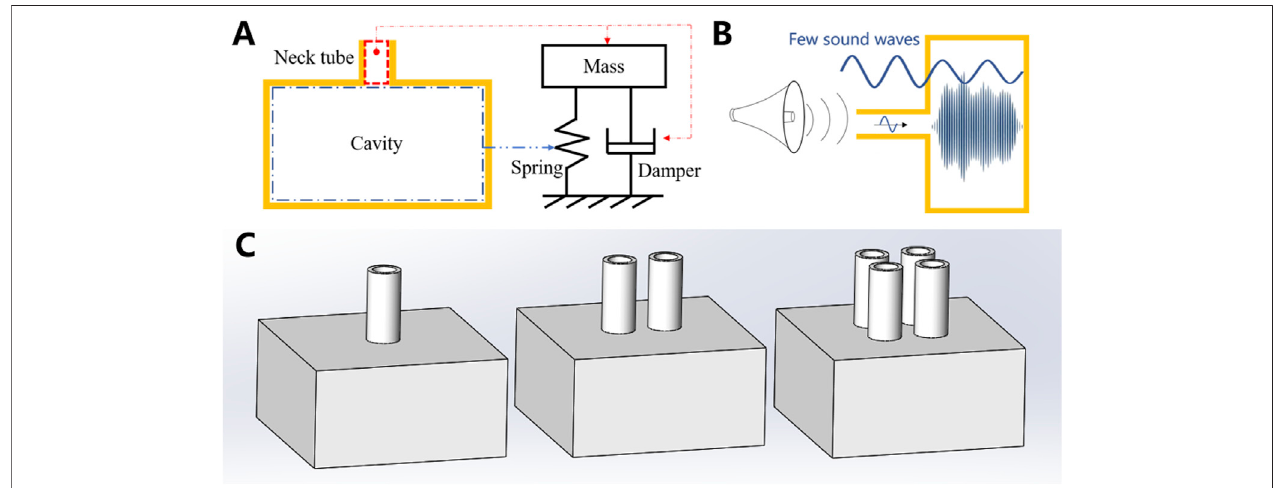
FIGURE 2| (A) Mass spring damping system of the typical Helmholtz resonator (B) Propagation process ofacoustic wave excitation through Helmholtz resonator (C) Structure diagrams of Helmholtz resonators with single tube, with dual tubes, and with four tubes.